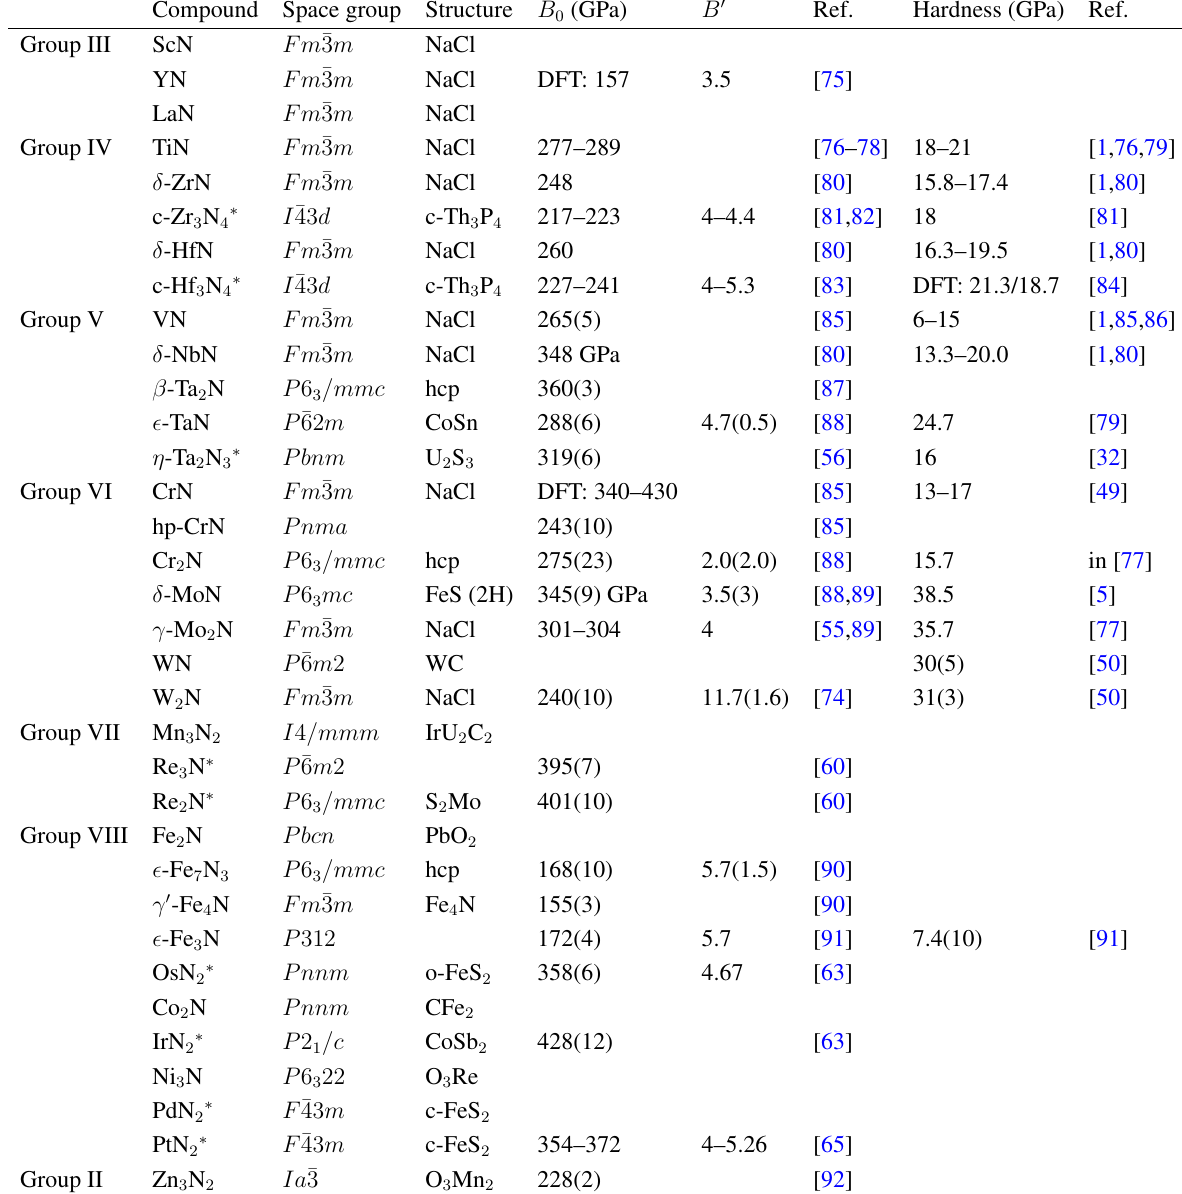
Table 1. Properties of selected transition metal nitrides. B pressure derivative. ∗ indicate phases obtained at high-( p, T )